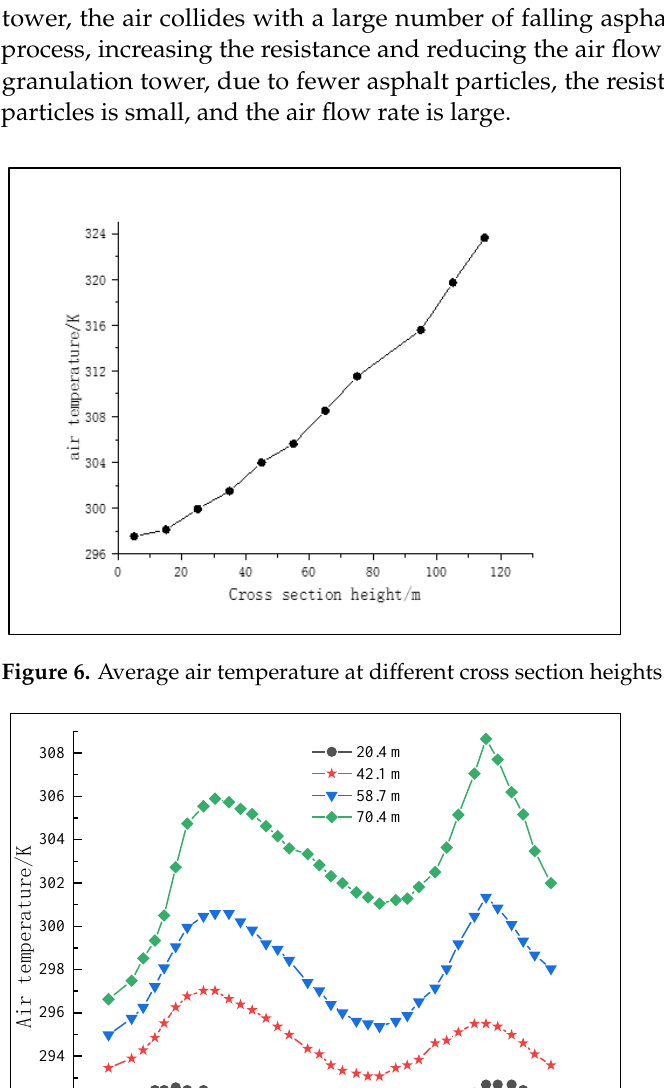
Figure 5. Air isotherm cloud chart.